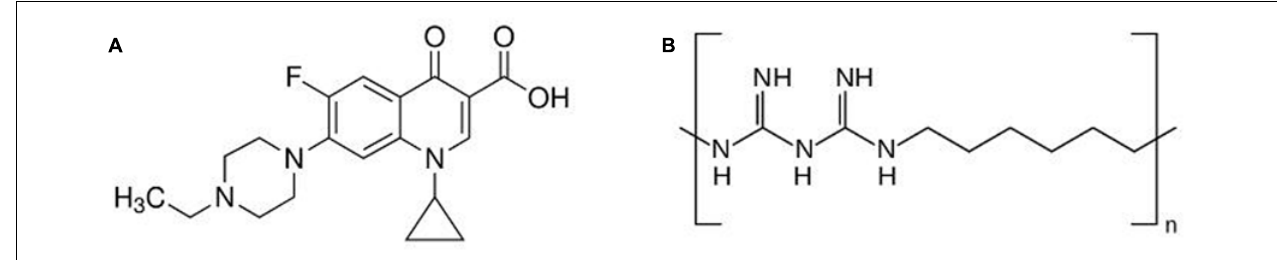
FIGURE 1 | Structure of (A) enrofloxacin and (B) polyhexamethylene biguanide ( PHMB). Enrofloxacin is a fluoroquinolone with mw of 359.4 g/mol. PHMB is a cationic polymer of repeating hexamethylene biguanide groups, with n average = 10–12 ( n is the number of structural unit repeats) and molecular weight (mw) 3025